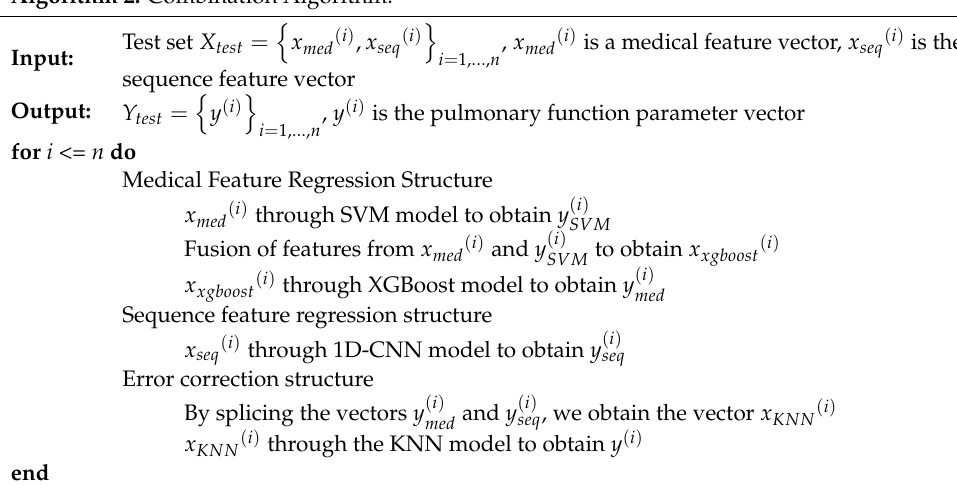
Algorithm 2: Combination